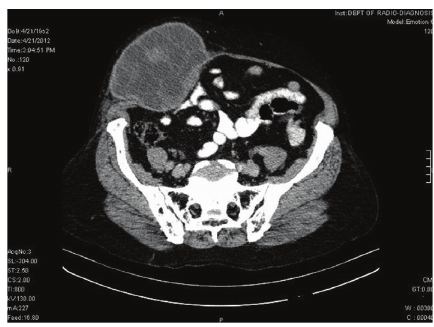
Figure 4: Intraoperative subcutaneous